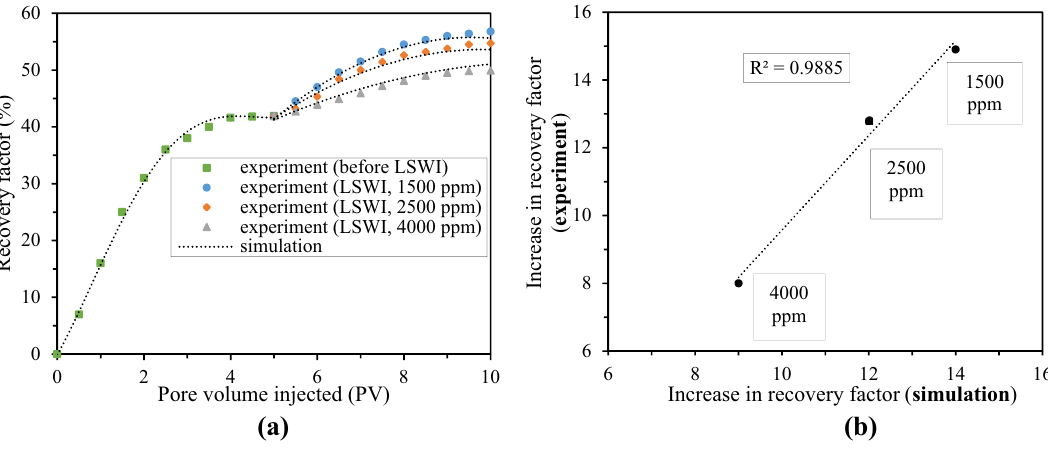
Fig. 3 The comparison of the experimental and simulation results of the recovery factor at various values of pore volume injected a and the increase in recovery factor after 10 PV b during LSWI